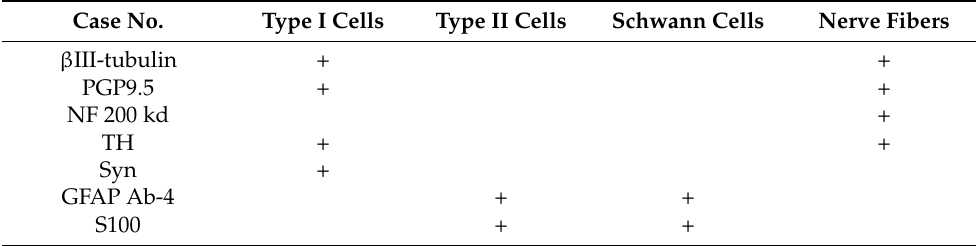
Table 2. Expression of markers in different structures of the human carotid body. Case